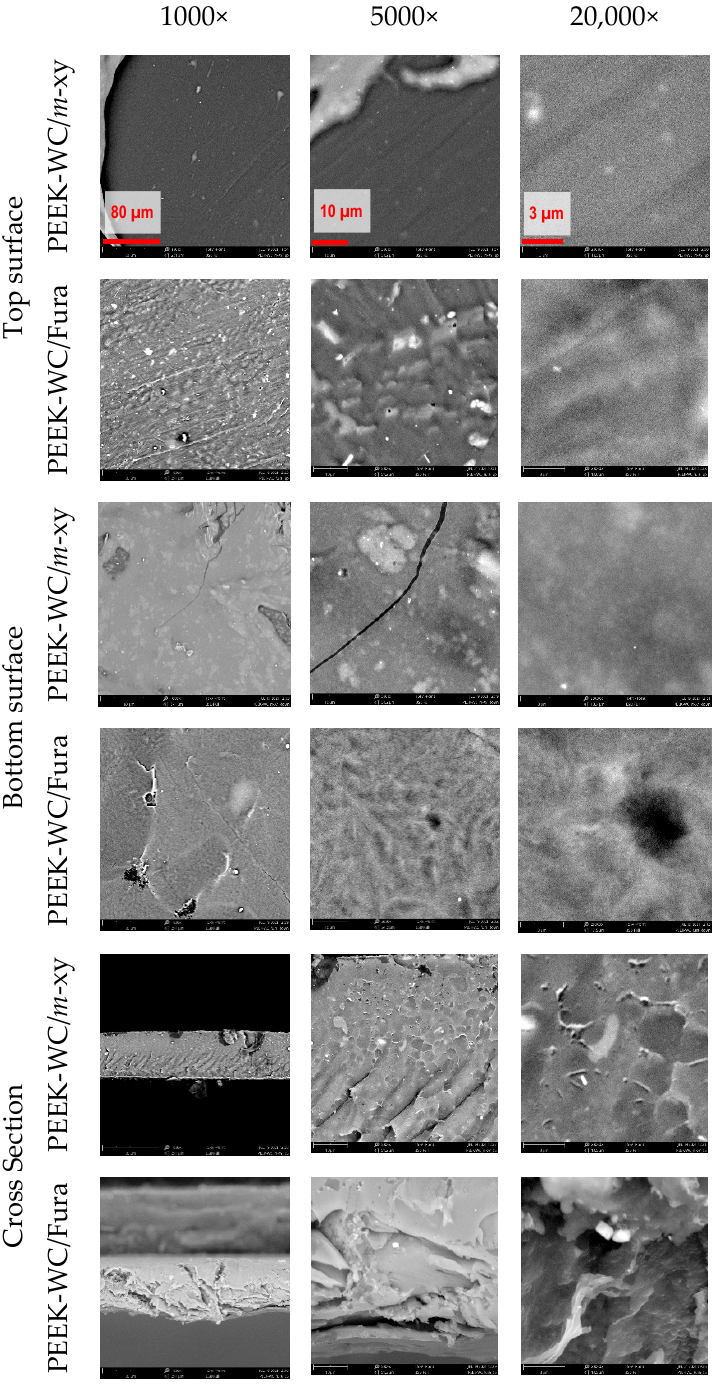
Figure 5. SEM images of the PEEK–WC-based membranes and the cages Fura ( 1 ) and m -xy ( 2 ) at different magnifications.